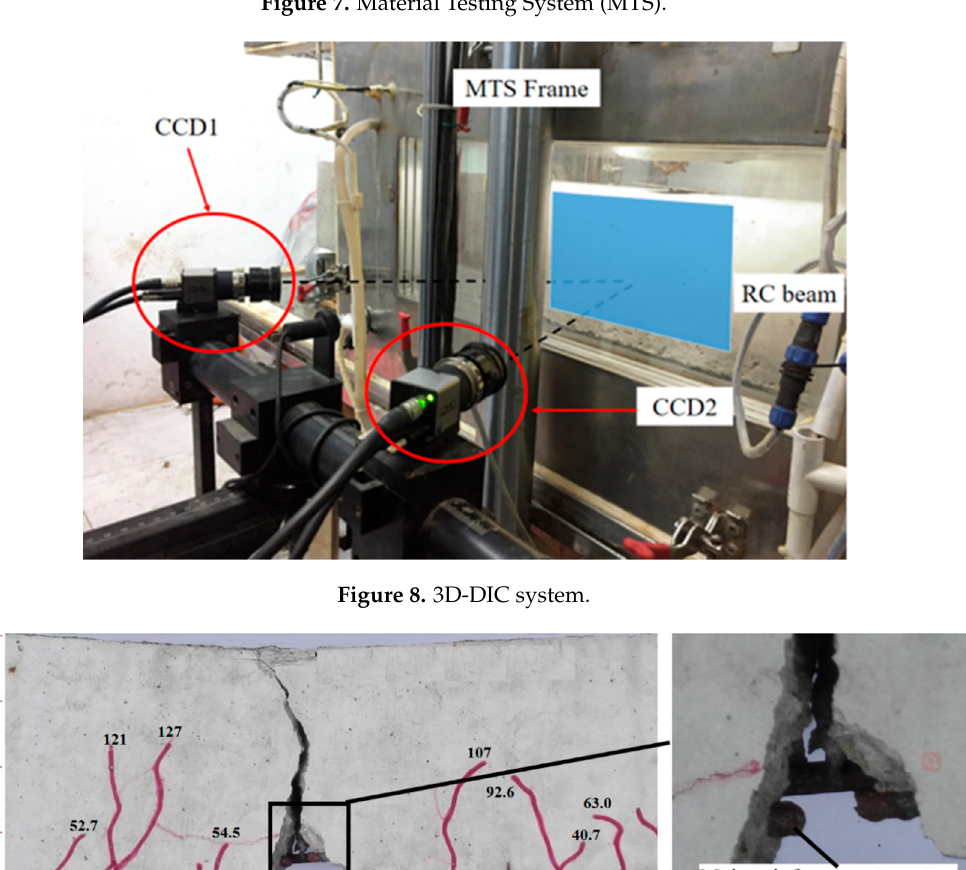
Figure 7. Material Testing System (MTS).